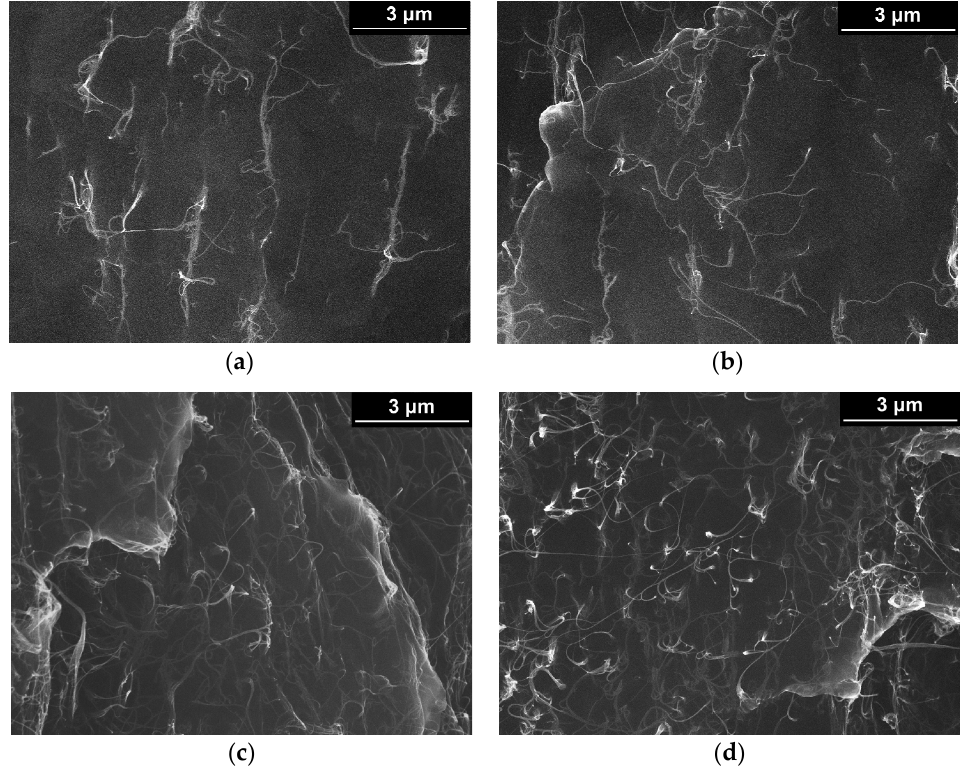
Figure 11. Results of scanning electron microscopy of low-temperature cleavages of the composites ( a , b ) PP + 0.5 wt.%